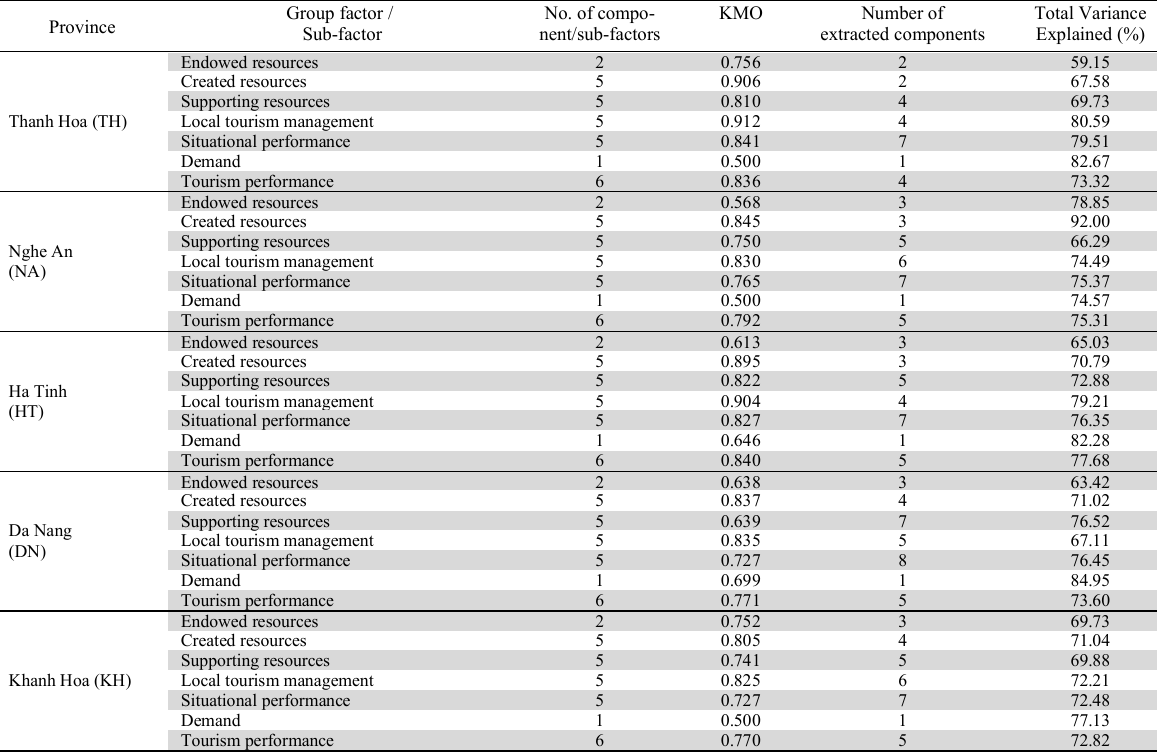
Results of exploratory factor